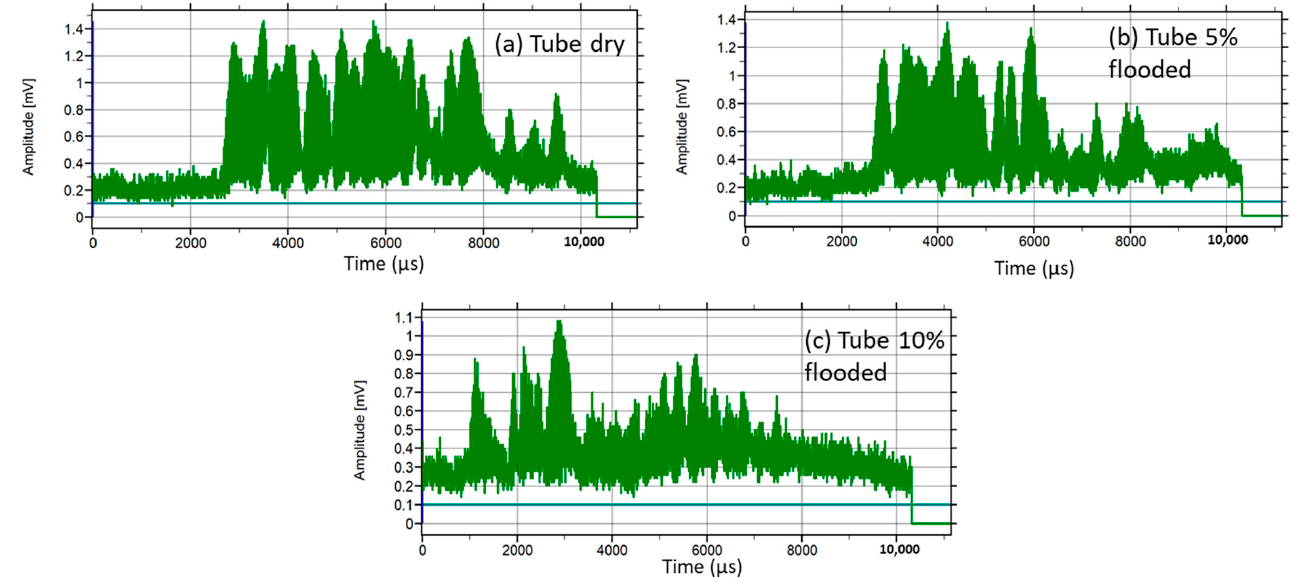
Figure 10. A received guided wave pulse: ( a ) dry tube, ( b ) tube loaded with 5% water, and ( c ) tube loaded with 10% water.